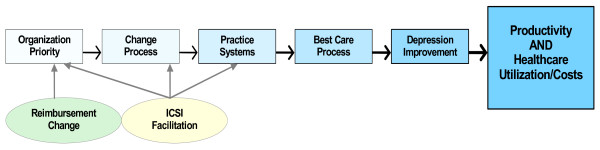
The implementation chain.